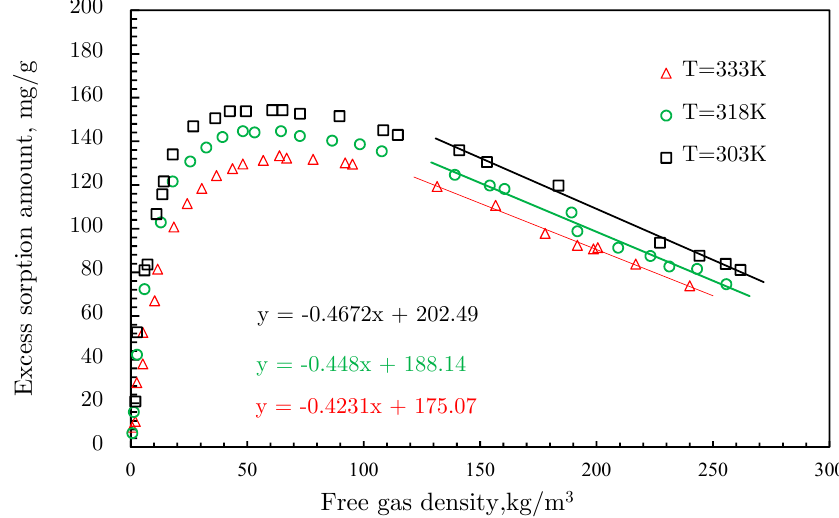
Figure 34. Excess sorption amount of methane in three different temperatures and the line segment after inflection point of maximum [80].